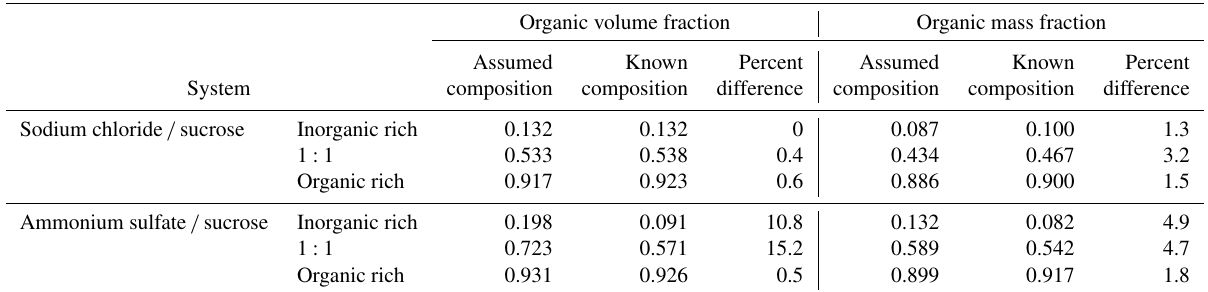
Table 3. Experimental and bulk values for organic volume fraction and organic mass fraction under different assumptions about the inorganic and organic component. The difference between OVF values using the known composition vs. using sodium chloride and adipic acid is also